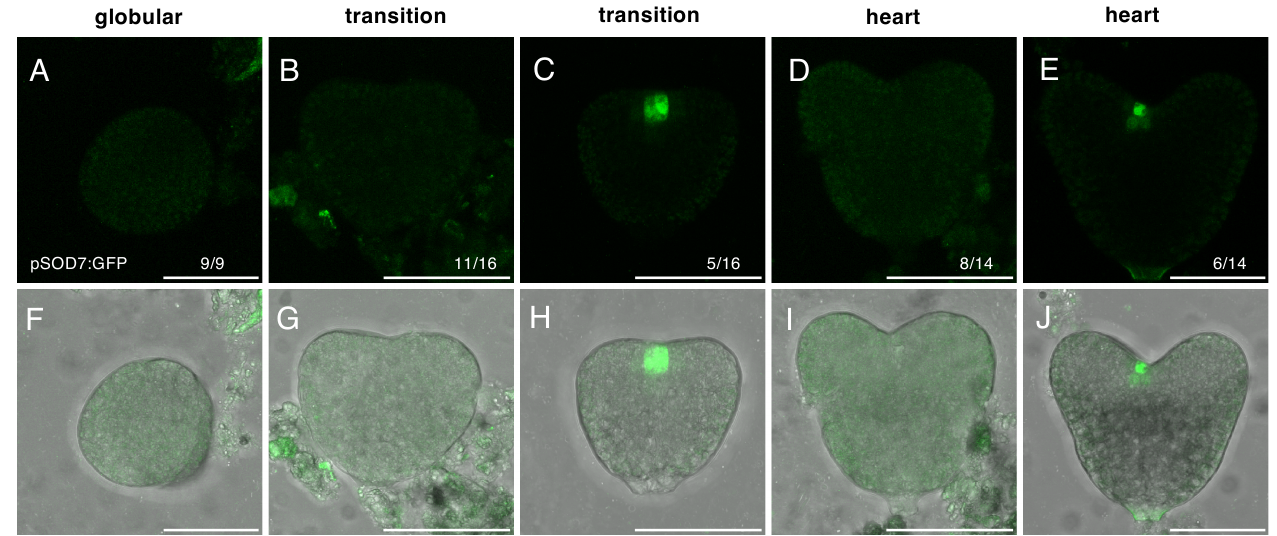
Figure 4. pSOD7:GFP expression in developing wild-type embryos. Panels ( A – E ) show the pSOD7:GFP signal (in green), while panels ( F – J ) show overlays of the pSOD7:GFP signal (in green) and the transmission picture (in grey). Images are maximum projection form stacks of confocal images. The number of similar observations out of the total number of observations is shown in the lower right corner as a fraction. The embryo stage is indicated above the panels. For the transition and the heart stages, an embryo without or with pSOD7:GFP expression are shown. Scale bars = 50 µm.